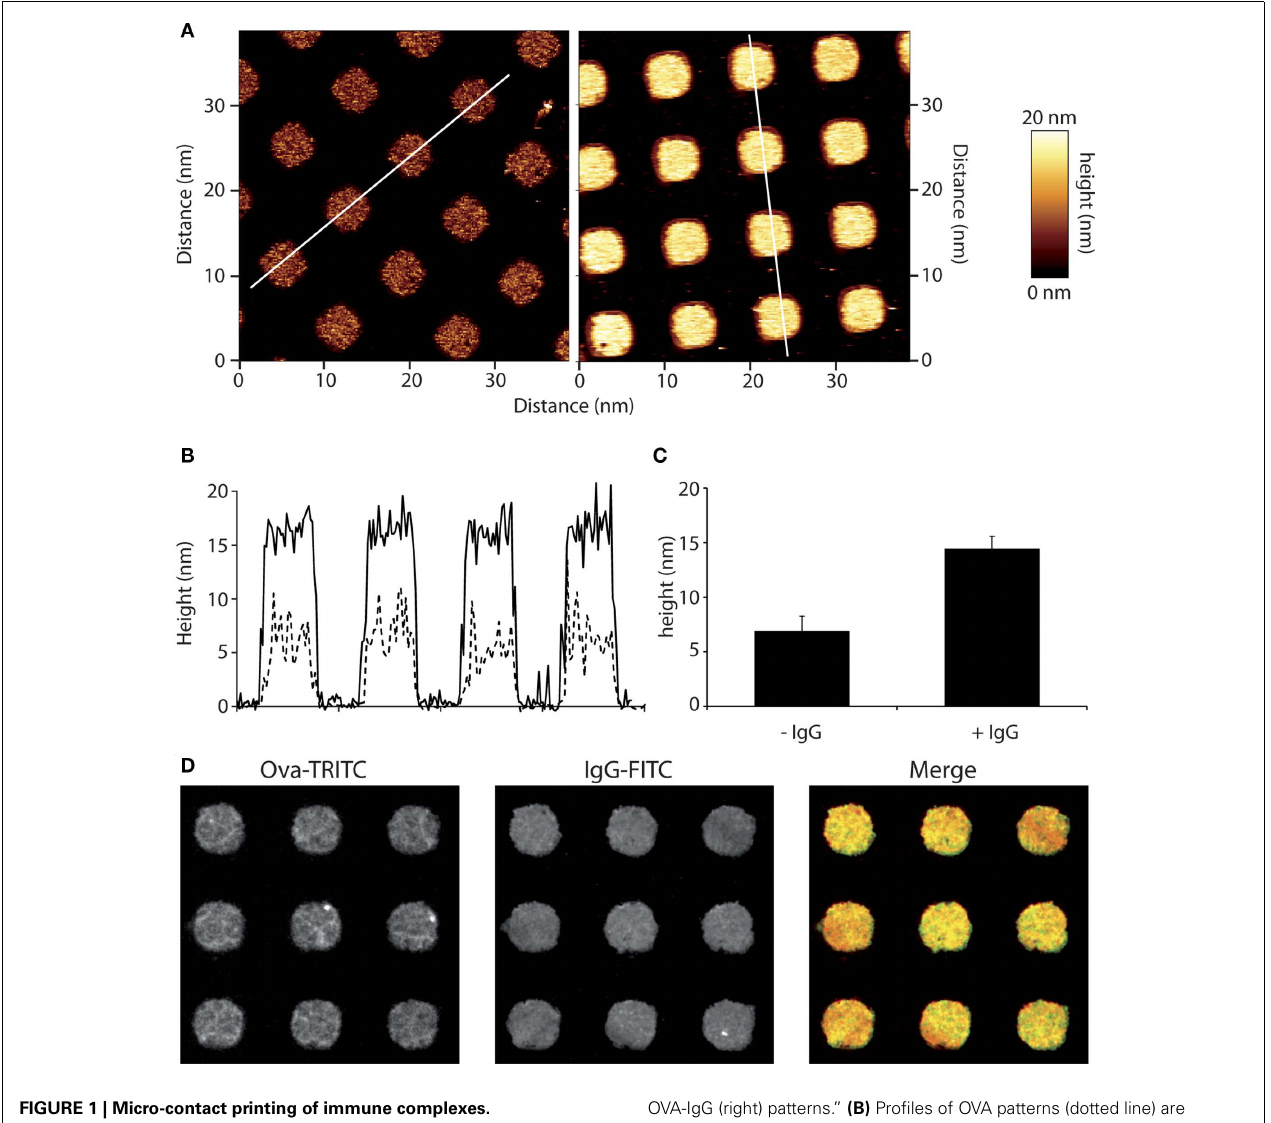
FIGURE 1 | Micro-contact printing of immune complexes. Micro-patterns of ovalbumin (OVA) were applied to glass cover slips and those were then incubated with anti-OVA antibodies. (A) Micro-patterned surfaces were scanned by AFM. Squares of 4 μ m-sides are separated by 5 μ m. Heights were measured as detailed in the Section “Materials and Methods" for OVA alone (left) and